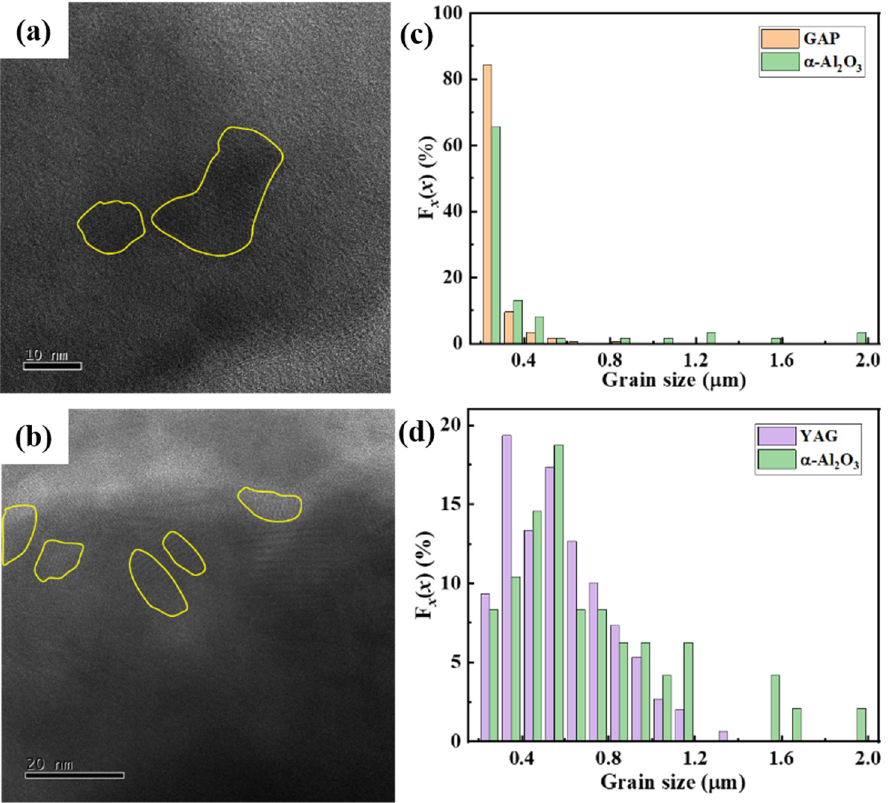
Figure 4. ( a ), ( b ) HRTEM images of as-sprayed Al 2 O 3 -GAP amorphous coatings after heat treatment at 1173 K and 1223 K for 10 min; ( c ), ( d ) grain size distribution of different crystalline phases in Al 2 O 3 -GAP and Al 2 O 3 -YAG amorphous coating. Table 3. A series of evaluation parameters of thermal stability for Al 2 O 3 -YAG and Al 2 O 3 -GAP amor- phous materials.